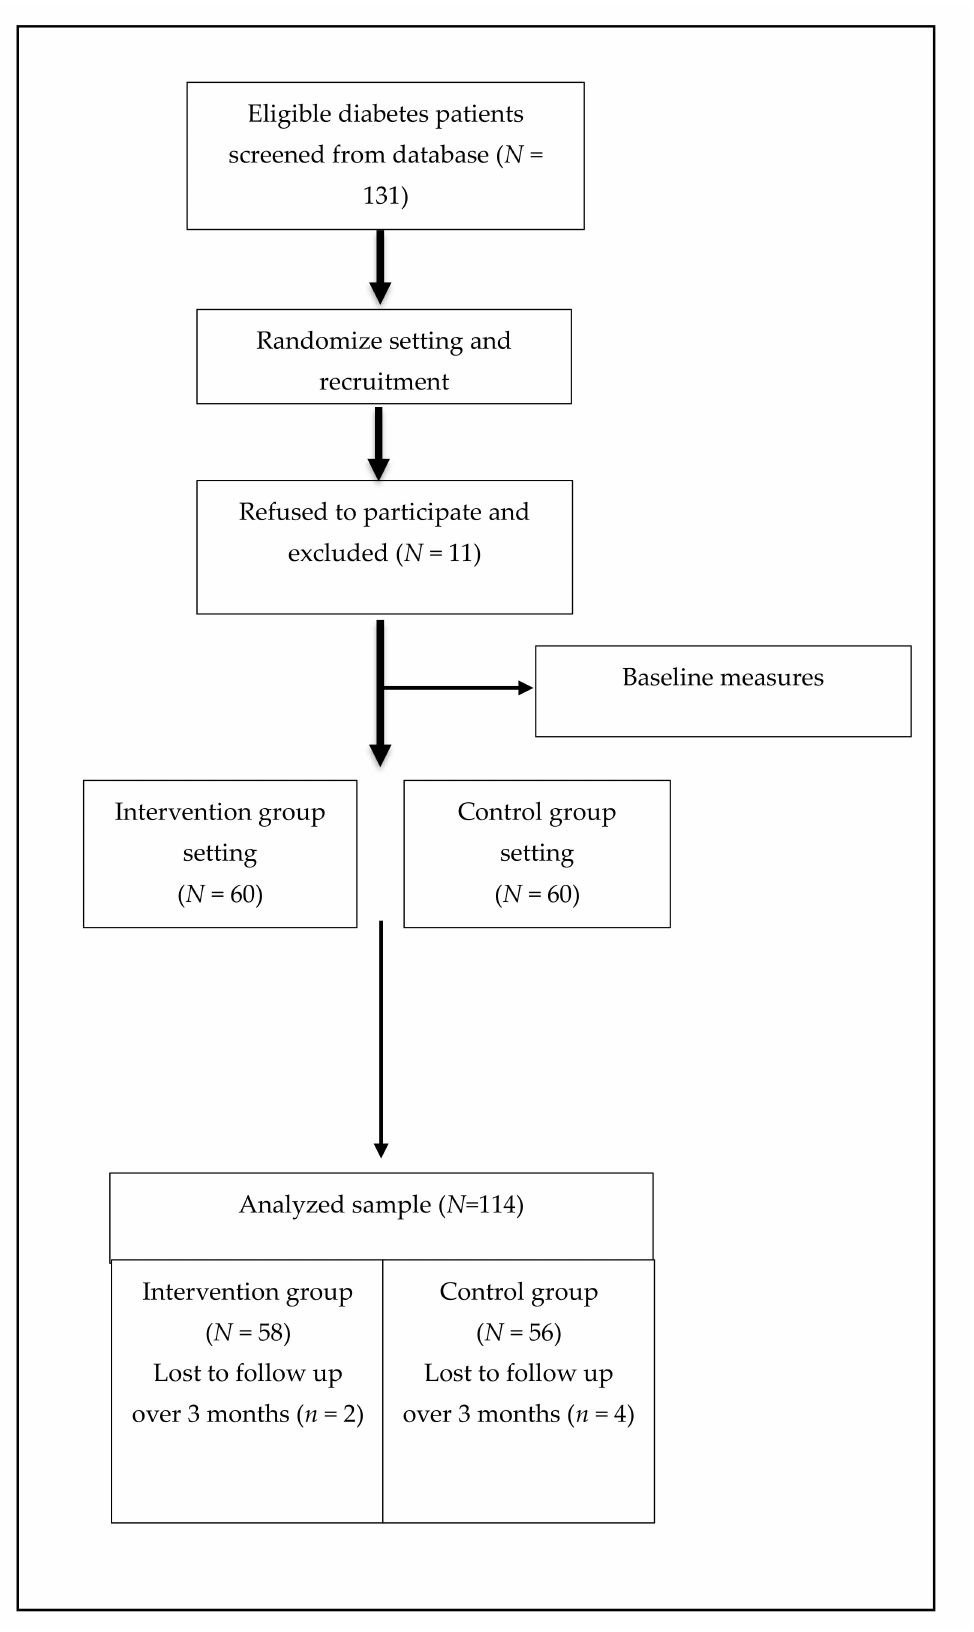
Figure 1. Flow diagram of participants: recruitment, intervention and